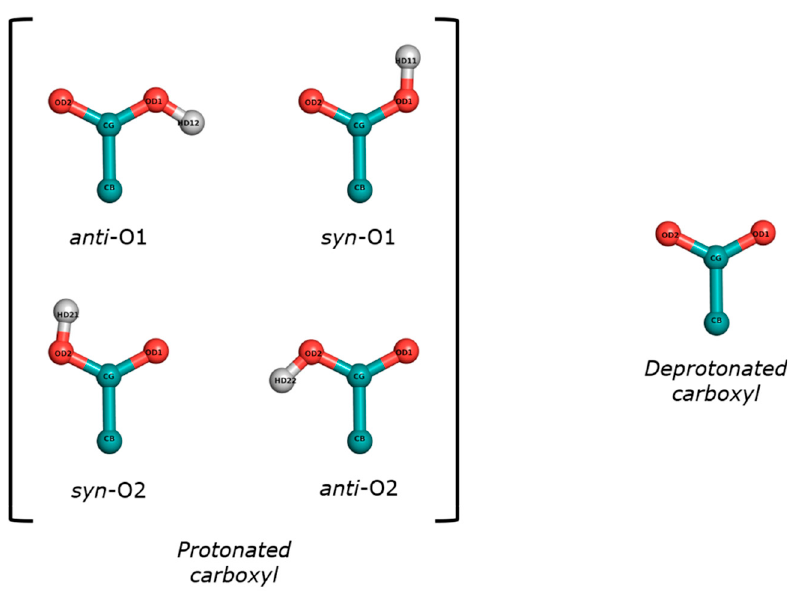
Figure 1. Protonation states of the carboxyl group in the side chains of the AS4 or GL4 residues. There are four protonated states depending on the position ( syn or anti ) of the proton with respect to the charged oxygen.